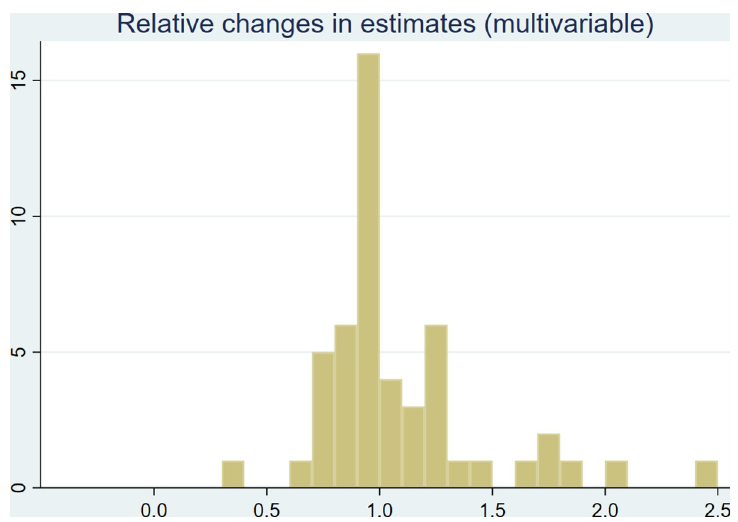
Fig 2. Histogram of relative changes in (multivariable) associations. The figure shows ratios of log odds ratios from reweighted and unweighted multivariable models. The bar width was set to 0.1.